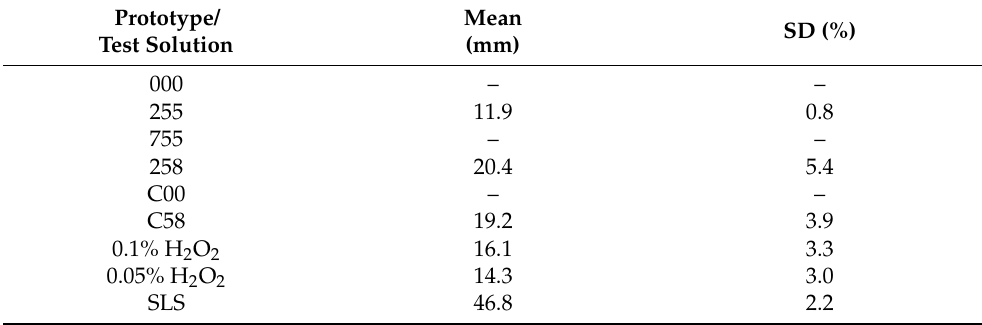
Table 2. Mean diameter (mm) in agar diffusion tests with S. mutans using ten toothpaste proto- types, hydrogen peroxide solutions (0.1 and 0.05%), and a sodium lauryl sulfate-containing control toothpaste (sodium lauryl sulfate (SLS) = Colgate, reference control